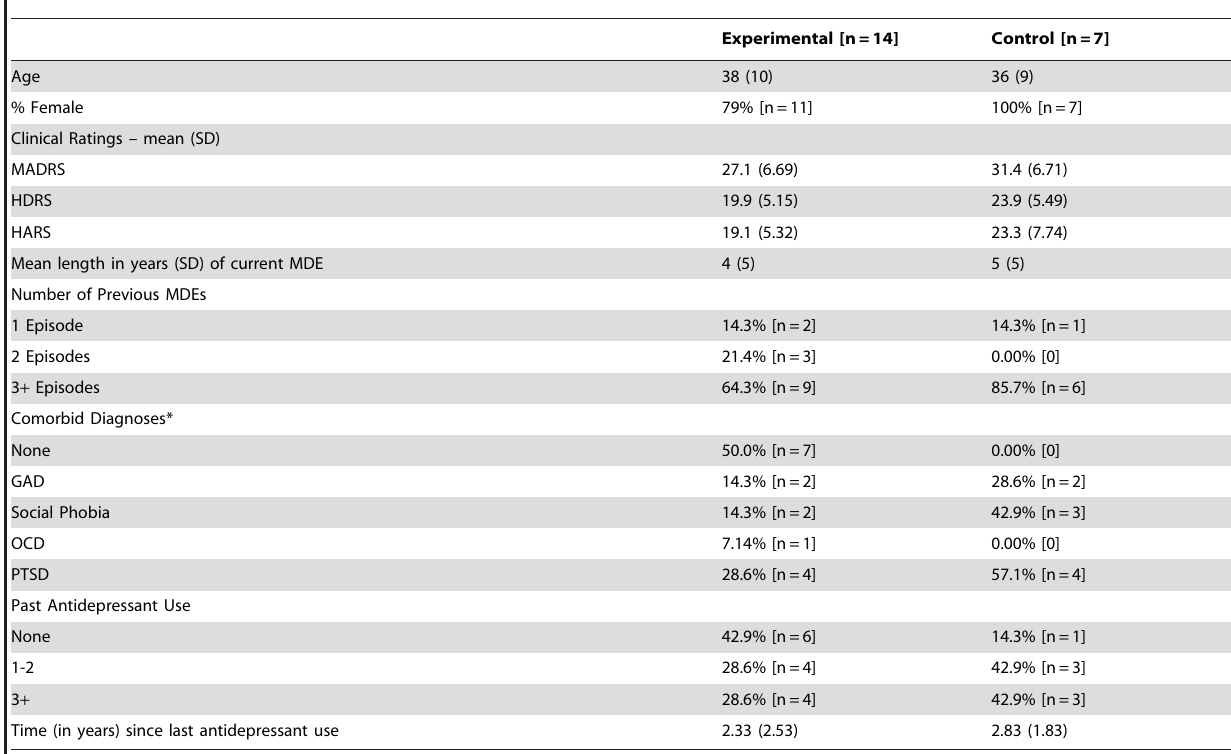
Table 1. Participant Characteristics by Experimental